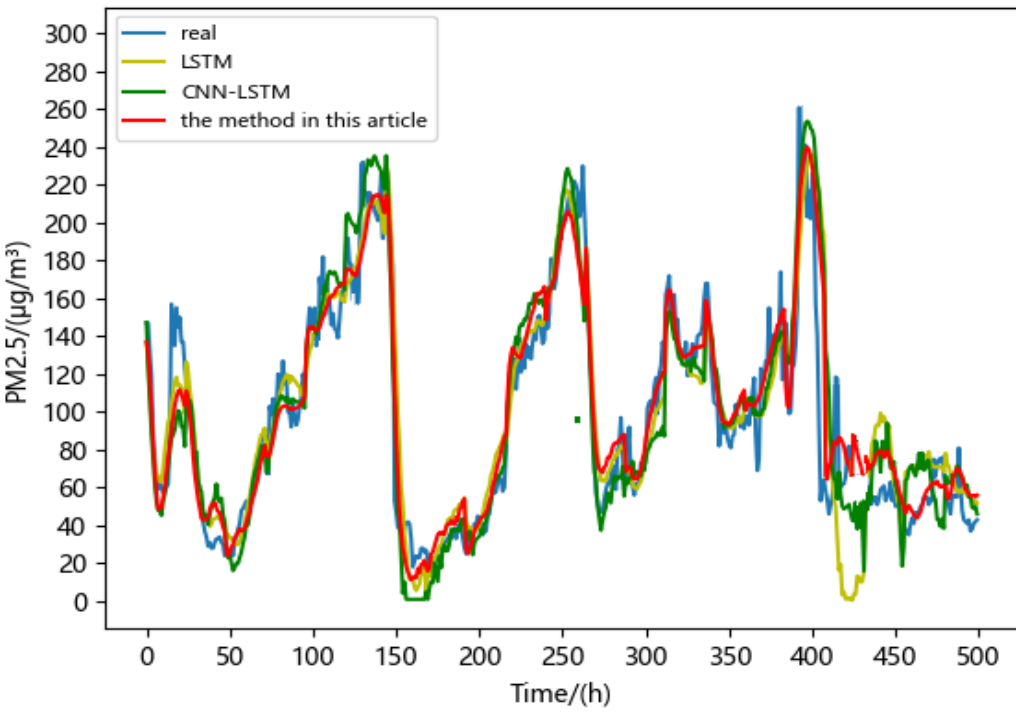
Figure 9. The prediction results of the three methods with a prediction step of 24 h.